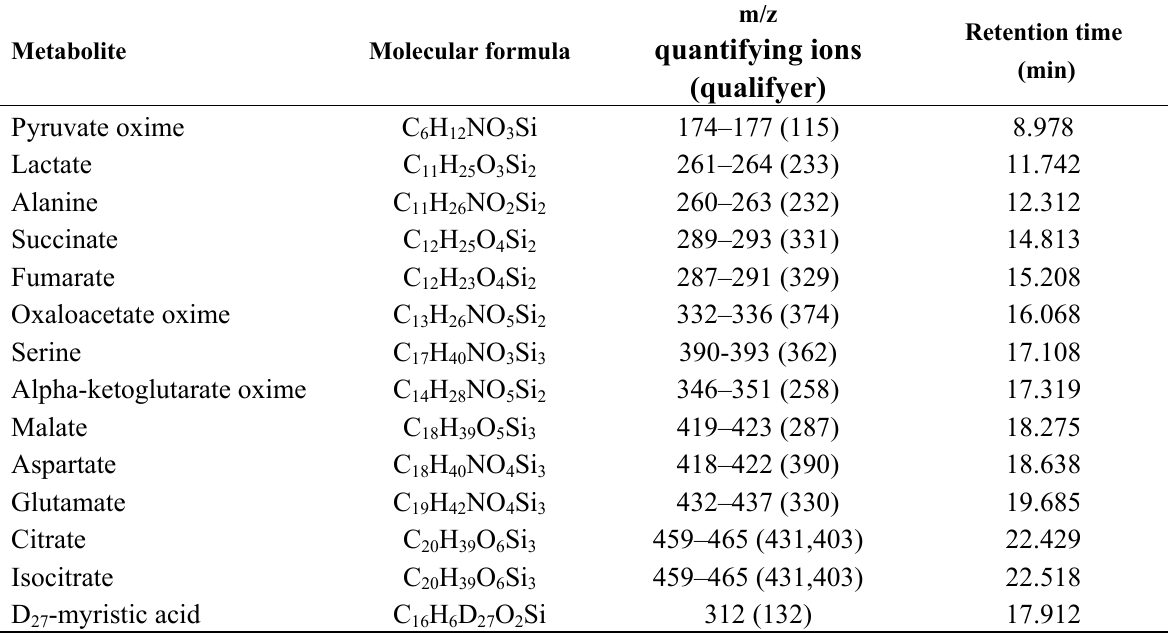
Table 2. List of metabolites monitored by GC/MS and fragments used for